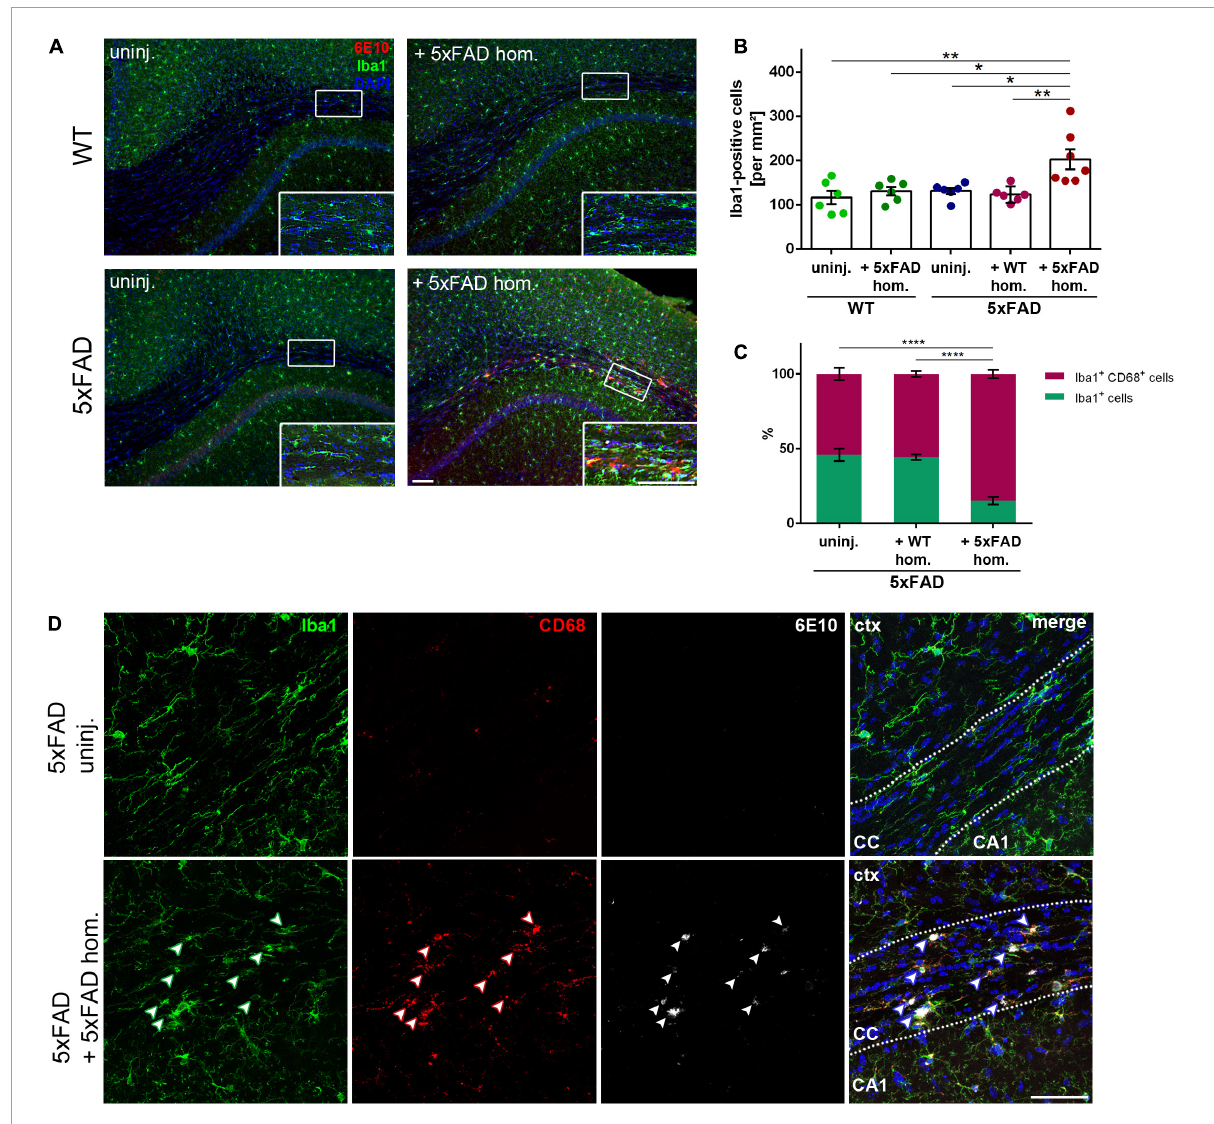
FIGURE2 Enhanced microglia density and phagocytic activity in the corpus callosum (CC) of amyloid-beta peptide (A β )-seeded mice. (A) Immunofluorescent Iba1 (green) and 6E10 (red) staining of 4-month-old WT and 5xFAD mice, which were either uninjected or injected with 5xFAD brain homogenate. Scale bar for overview and inset 100 µ m. (B) Respective quantification of Iba1-positive cells in the CC. n = 6–7 mice with n = 4–5 sections analyzed per animal. Each symbol represents data from one mouse. Mean ± SEM, Kruskal–Wallis test followed by Dunn’s multiple comparison test, * p < 0.05, ** p < 0.01. (C) Quantification of the ratio between Iba1 single-positive and Iba1 and CD68 double-positive cells in the CC of 5xFAD animals, either uninjected or injected with either WT or 5xFAD homogenate. n = 4–5 mice with n = 5 sections